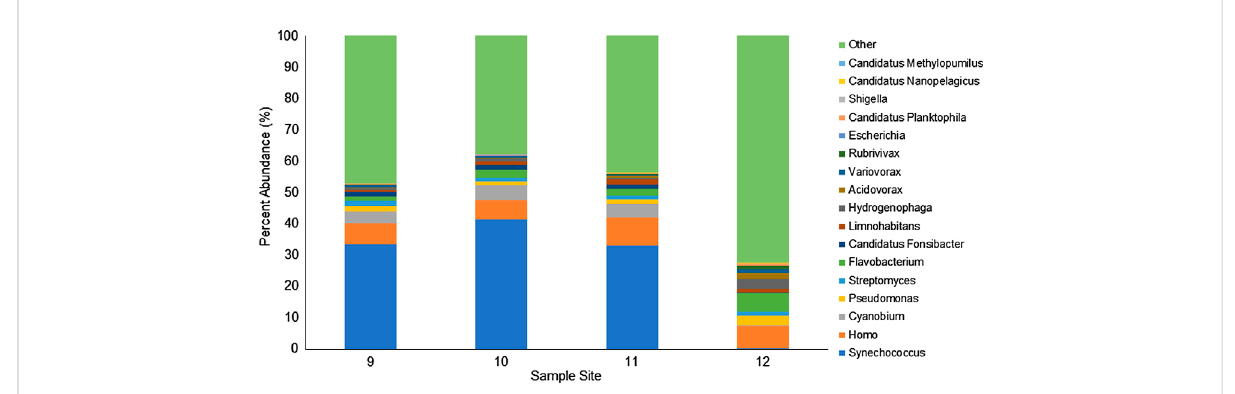
FIGURE 5 Relative abundance of WIMP identi fi ed genera for each agricultural water site. Reads were analyzed by the EPI2ME WIMP work fl ow. Bacterial genera contributing more than 1% of the classi fi ed reads are shown and the sum of the remaining genera identi fi ed are included as “ Other. ”